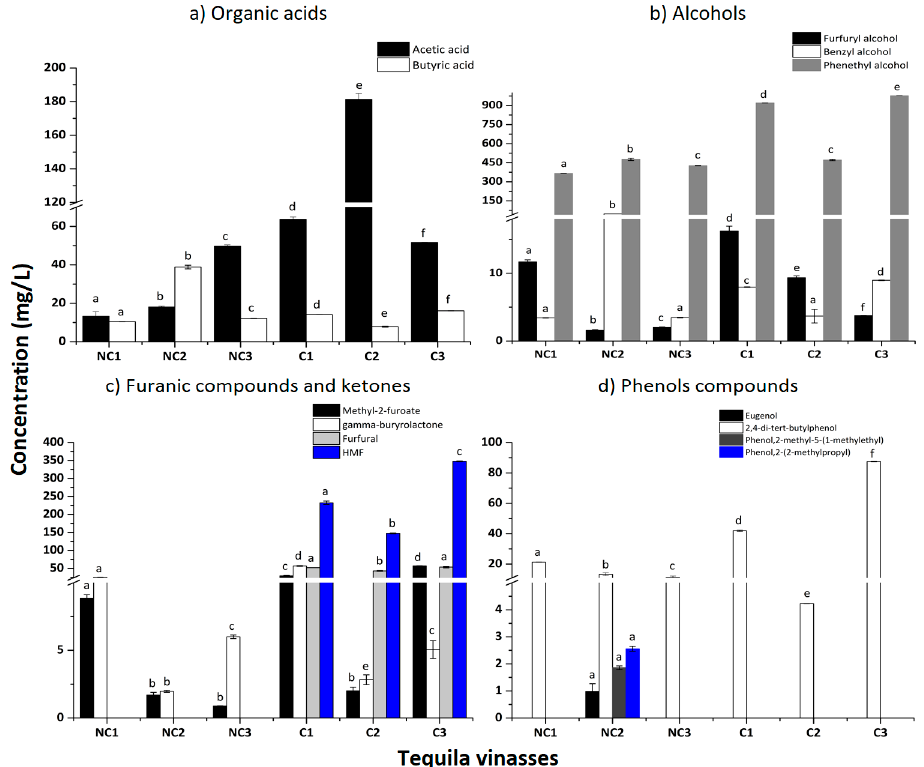
Figure 1. The total concentration of volatile compounds found in tequila vinasses from both processes (not-cooking (NC) and cooking (C)) by functional group. Bars represents mean ± standard deviation. Different lowercase letters indicate significant differences for each compound among the analyzed vinasses ( p < 0.05, an analysis of variance (ANOVA)).